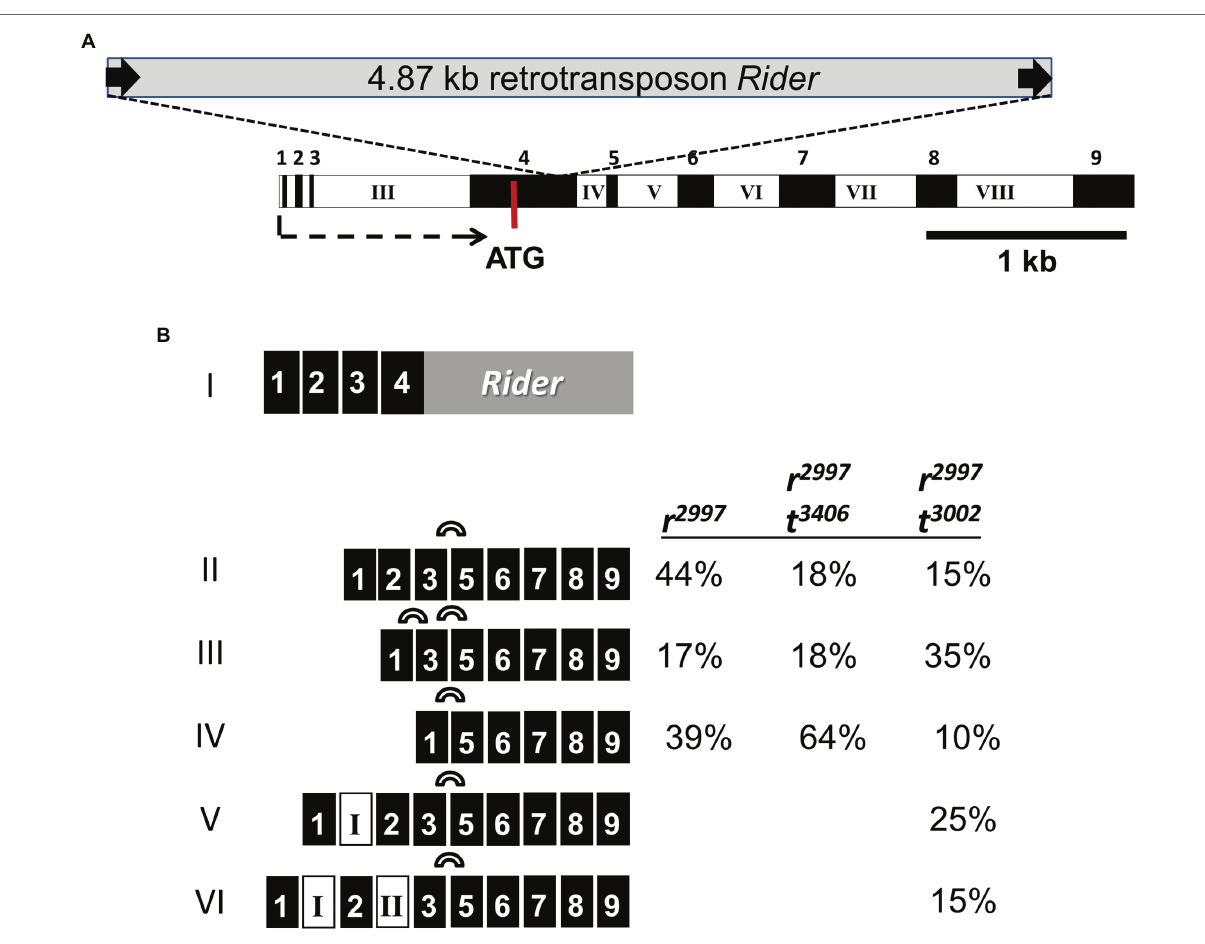
TABLE 1 | Carotenoid composition in ripe fruit of various tomato lines ( μ g g − 1 FW). Lutein Lycopene Prolycopene Neurosporene ζ -Carotene β